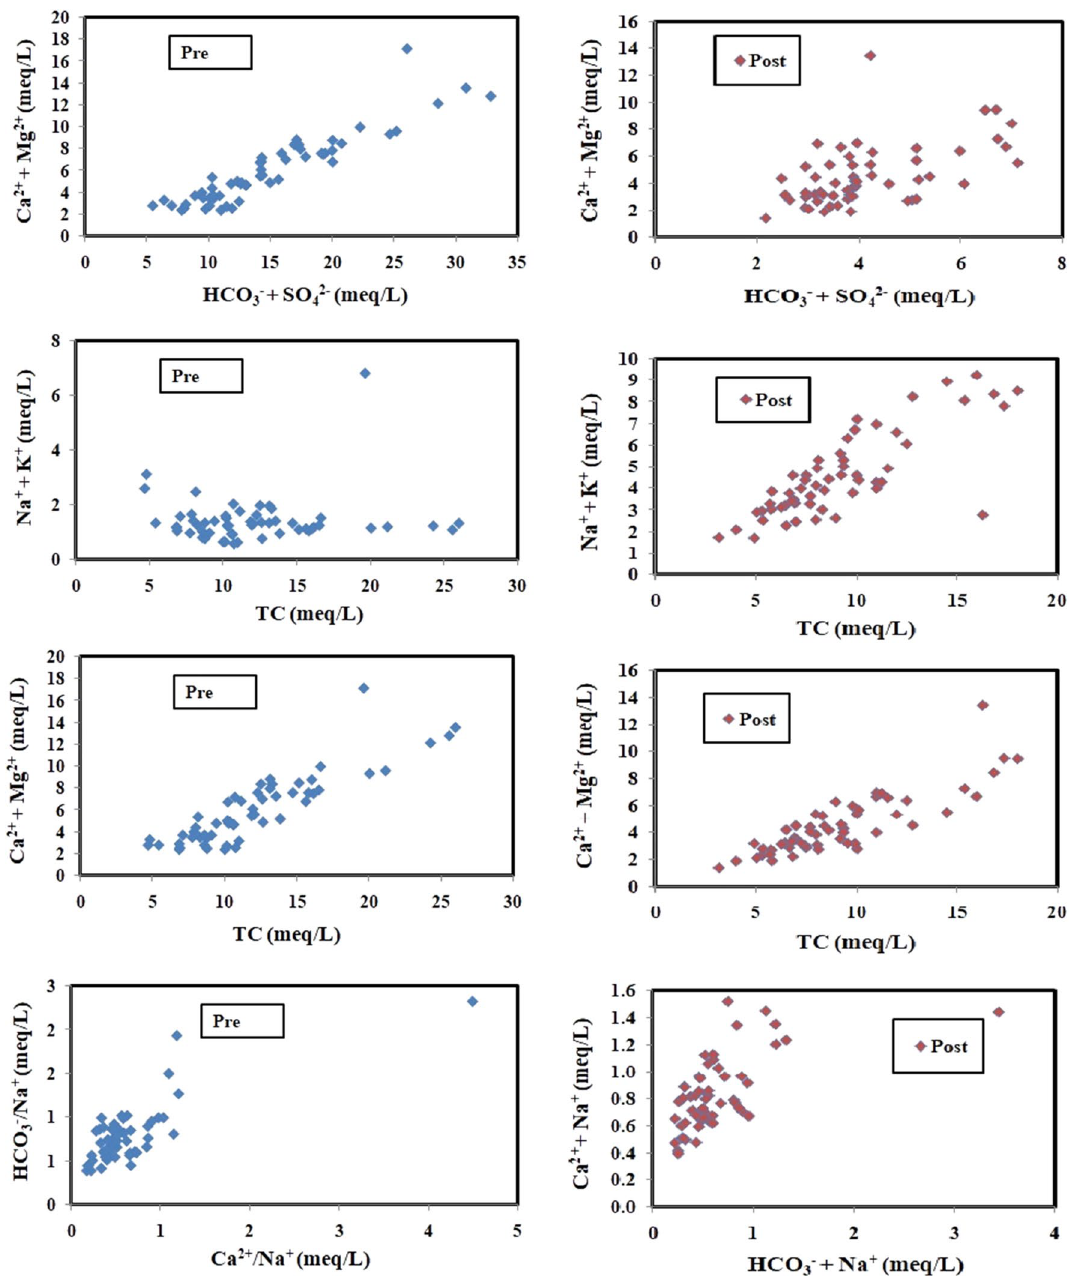
Fig. 12 Scatter plots showing (Ca 2+ + Mg 2+ ) vs. (HCO 3− + SO 42− ), Na + + K + vs. (TC + ), Ca 2+ + Mg 2+ vs. (TC + ), HCO 3− /Na + vs. Ca 2+ /Na +